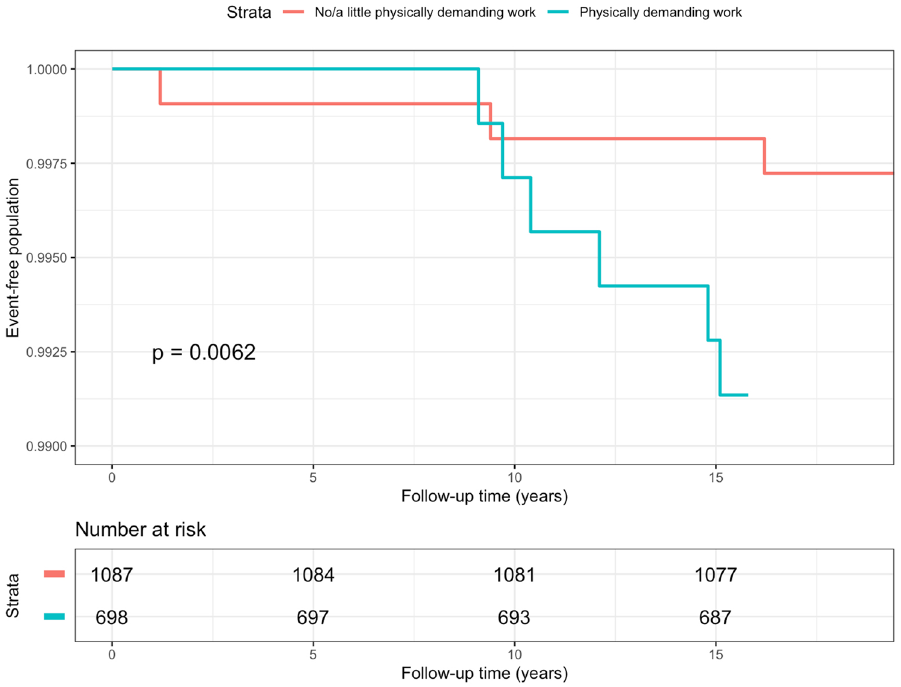
Figure 4. Kaplan–Meier curve of hospitalization for ulnar nerve entrapment among women in the subsample in follow-up 1997– 2018, stratified by physically demanding work at baseline. P-value for log-rank